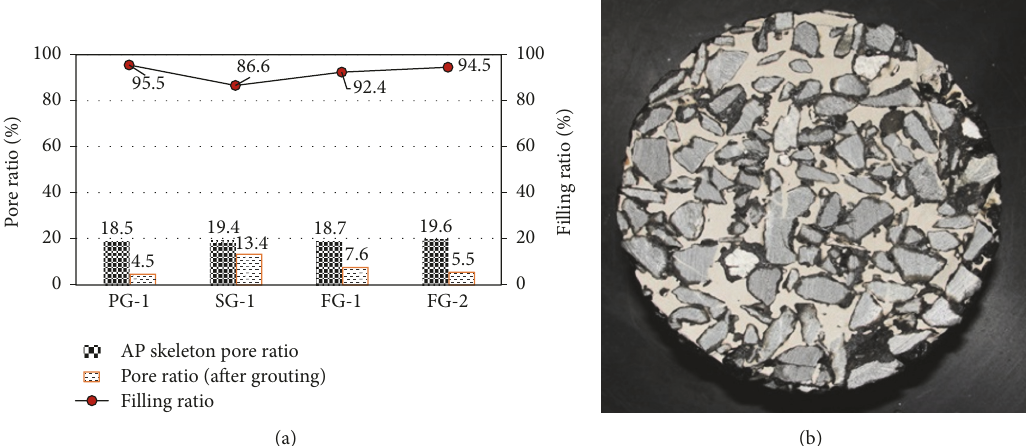
Figure 5: Pore ratio results of semirigid asphalt specimens. (a) Pore ratio results of semirigid asphalt specimens. (b) Specimen for porosity